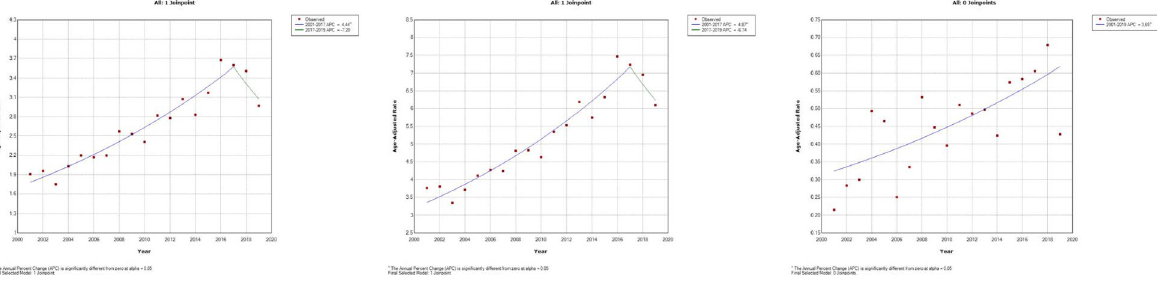
Fig. 2 Joinpoint regression analysis of WHO standardised incidence rates in laryngeal cancer from 2001 to 2019 including all histology types in Sri